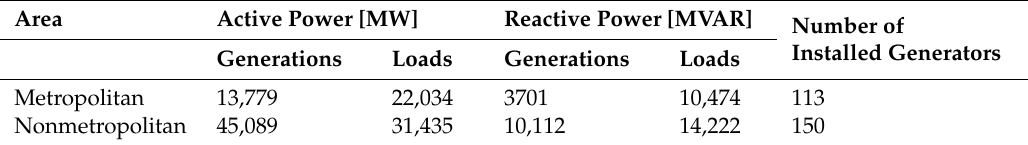
Table 2. Summary of the Korean power system.